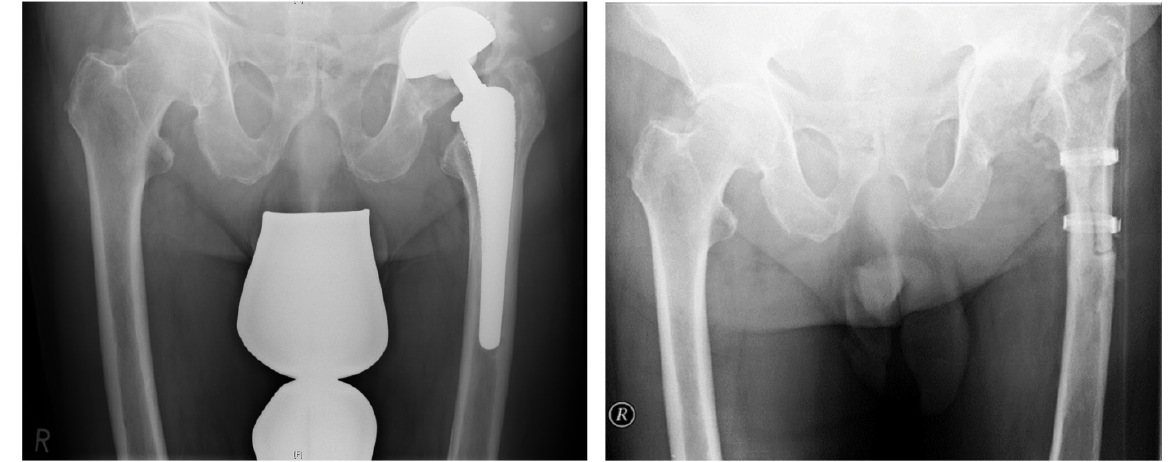
Figure 1: Pre- and postoperative AP pelvic radiograph of an infected THA. Explantation was performed by using an extended trochanteric osteotomy and re-fixation with two